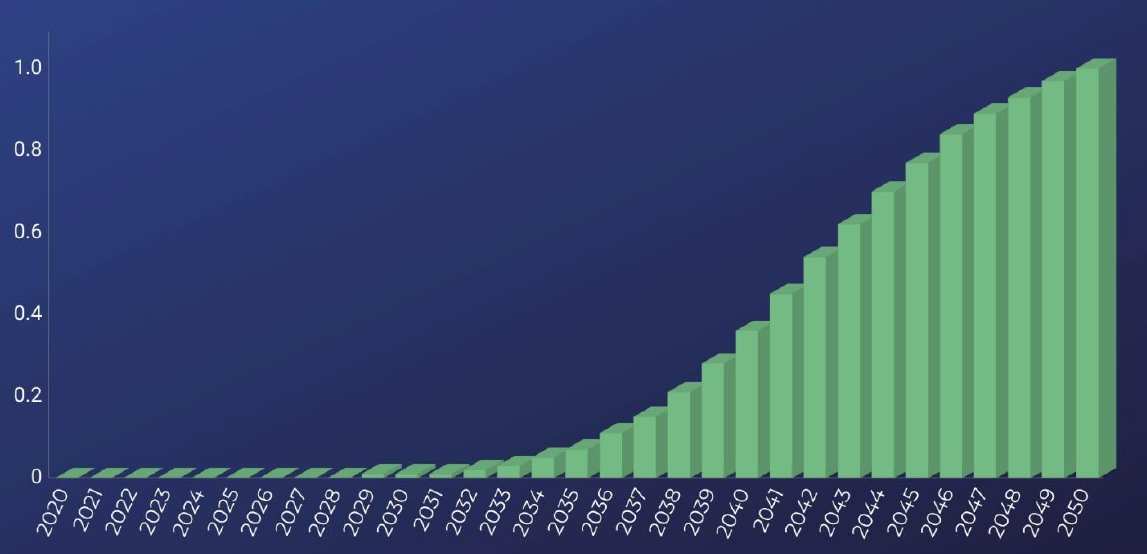
Figure 5. Technical efficiency (TE) of green hydrogen production in the UAE.